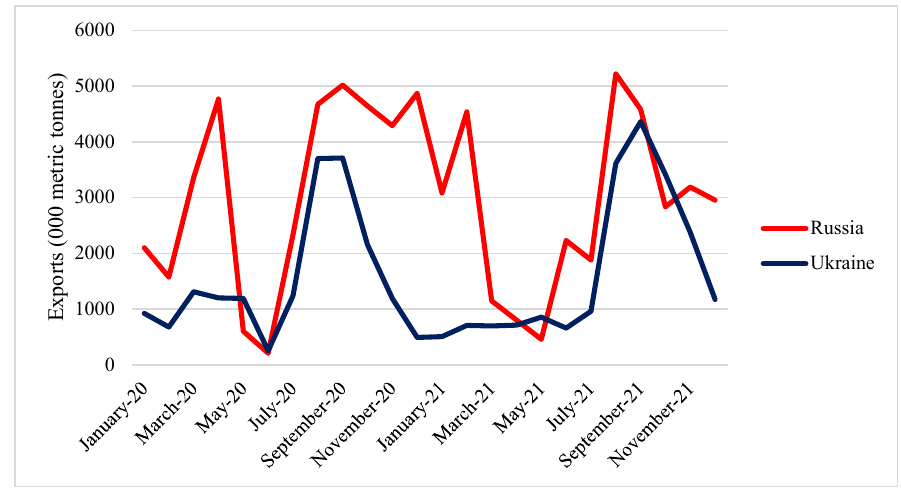
Figure 6. Export quantity of Russian and Ukrainian wheat in 2020 and 2021. Source: [30].